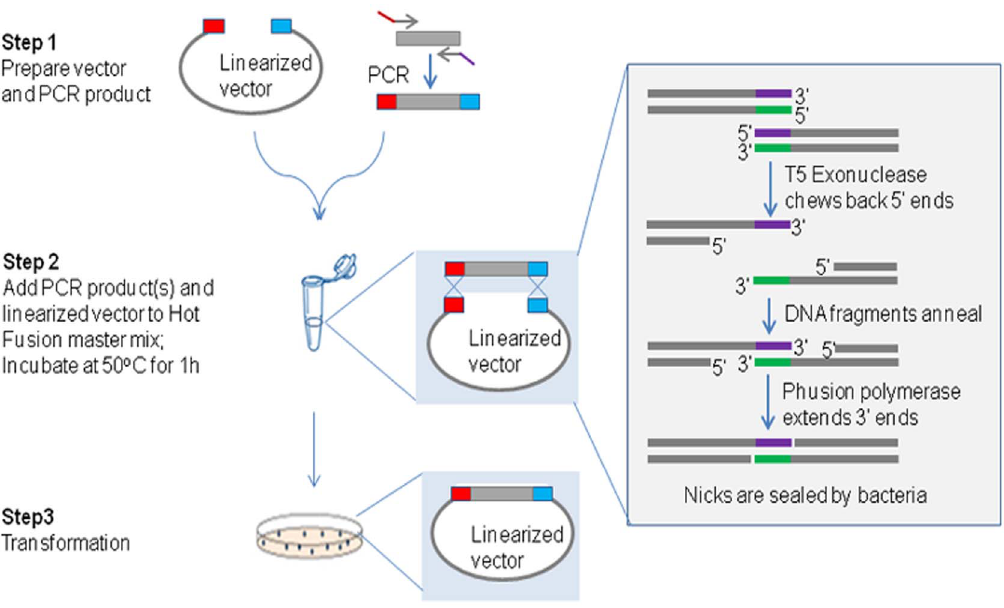
Fig. 1. A diagram of the Hot Fusion process for single fragment cloning. Red and blue boxes on the vector and PCR product indicate the overlapping sequences (17–30 bp). T5 exonuclease removes nucleotides from the 5 9 to 3 9 end of double strand DNA molecules. Phusion DNA polymerase fills in gaps that are over-generated by T5 exonuclease. Annealed fragments are transformed into E. coli and the nick sites in the nucleotide chain are repaired by E. coli.